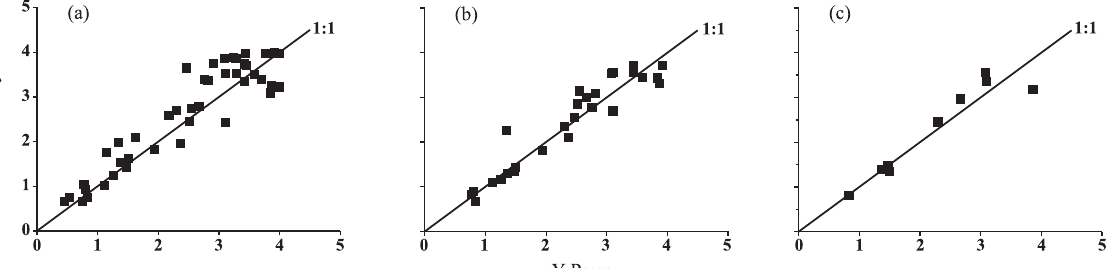
Figure 2. Scatter diagrams relating the soil acidity buffering factor Y calculated from measured remaining phosphorus (Y-Prem ) to values calculated from remaining phosphorus (Y-Prem m neural network-based pedotransfer functions developed from testing datasets consisting of 50 (a), 30 (b) and 10 % (c) of the total data. = 4.002 – 0.125901 Prem + 0.001205 Prem 2 – 0.00000362 Prem 3 (Alvarez V. et al., 2000).